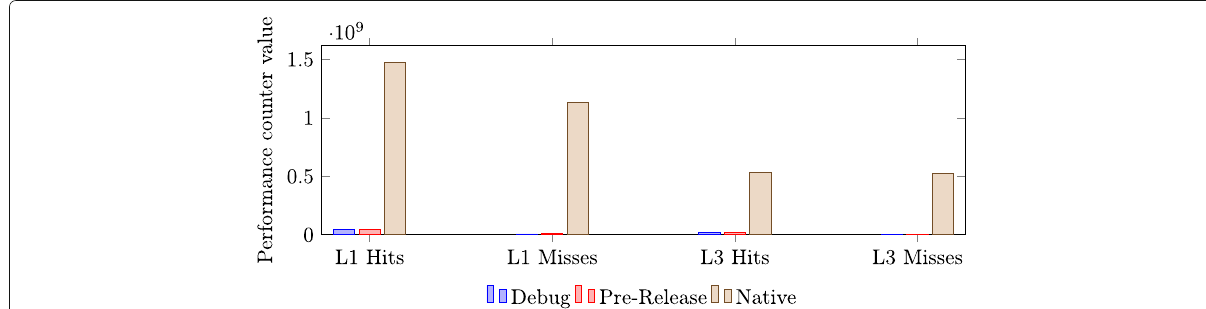
Fig. 13 Performance counters for caches are disabled in an enclave. Flush+Reload of one variable in a loop results in a high cache activity, which can be seen in native environment, but not on SGX debug or pre-release mode